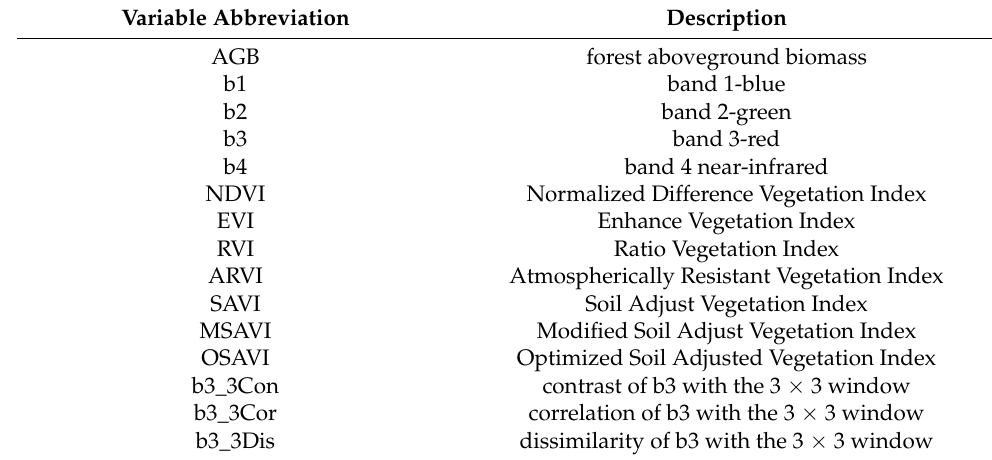
Table A1. Variable abbreviation in correlation